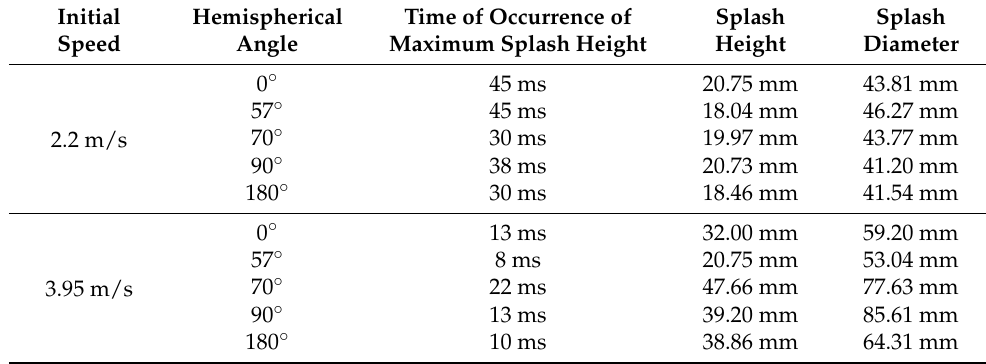
Table 3. Water splash experiment data of the hydrophilic